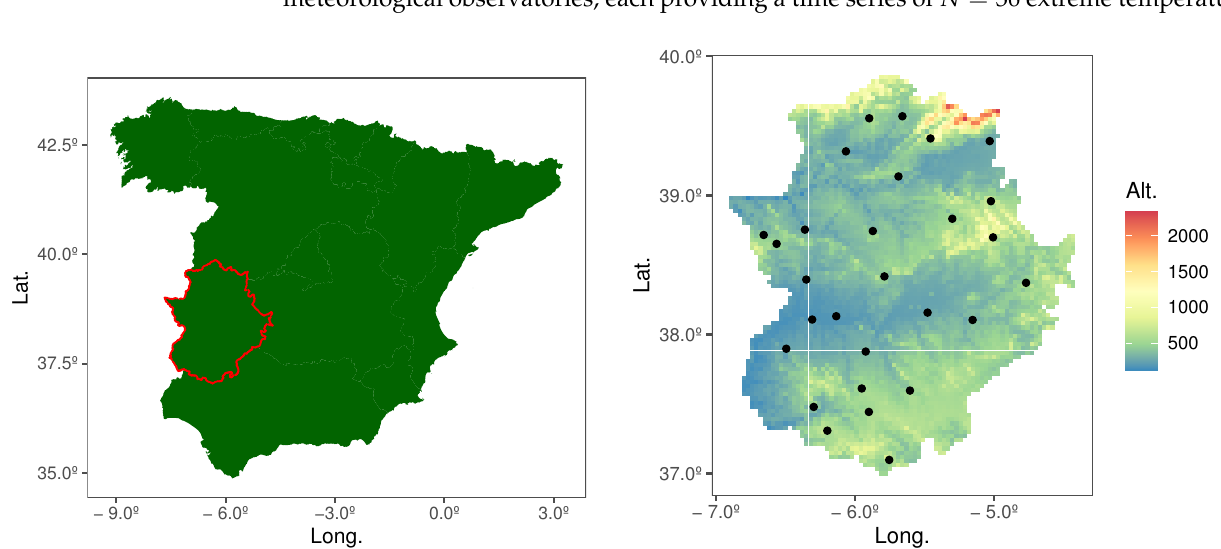
Figure 2. Location of the Extremadura Region within Spain ( left ). Topographic map of Extremadura together with the locations of the meteorological observatories used in this study ( right ).